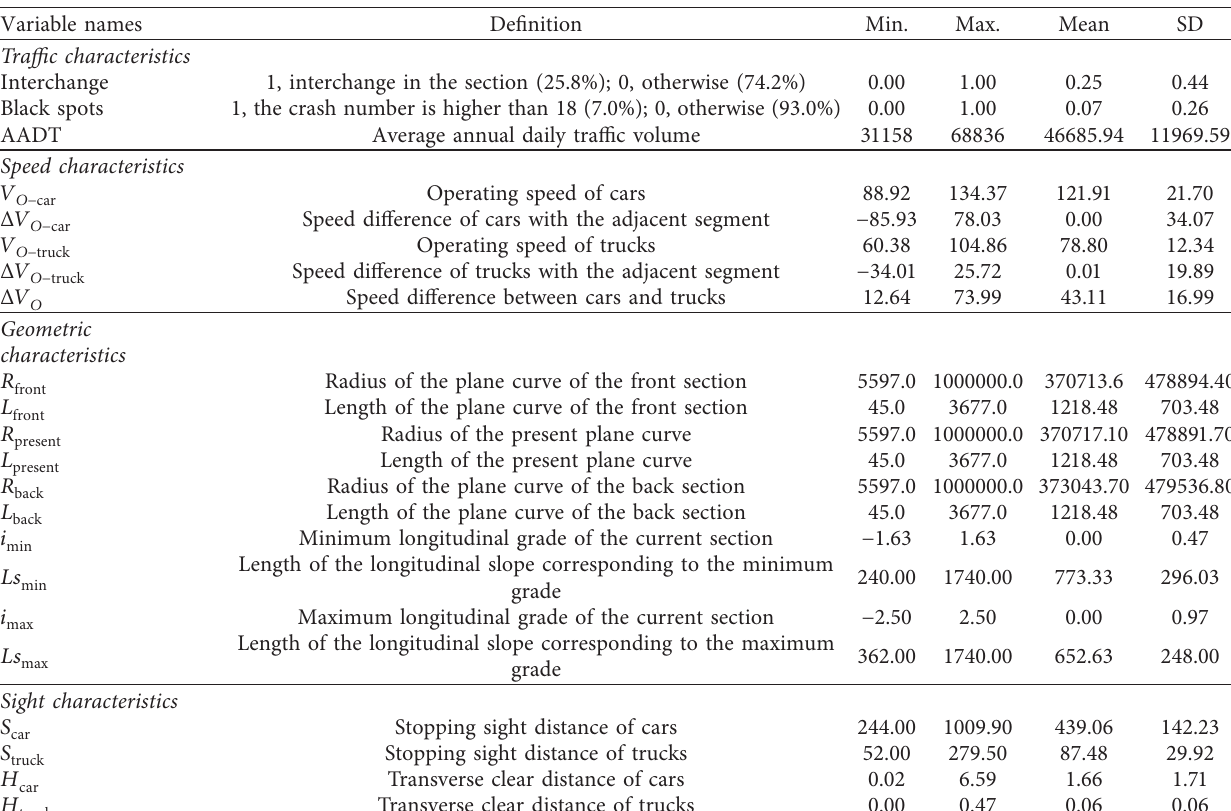
Table 2: Summary statistics of independent